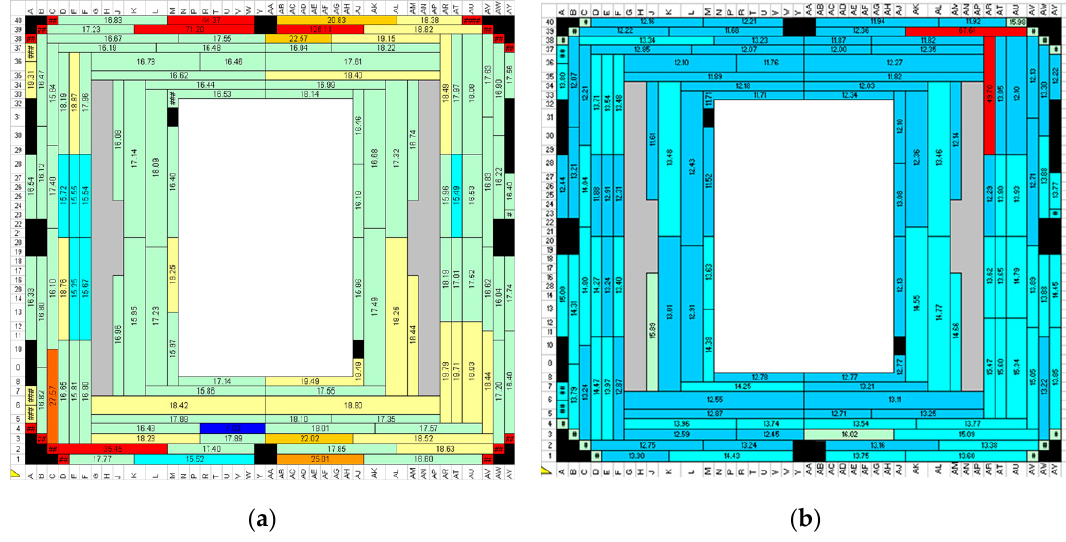
Figure 8. Selected R LLCR map of failing units. ( a ) Failing unit No 1; ( b ) failing unit No 2. R map of failing units. ( a ) Failing unit No 1; ( b ) failing unit No 2. Figure 8. Selected LLCR